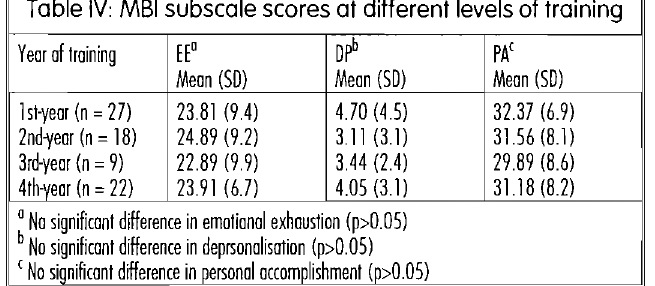
Table IV: MBI subscale scores at different levels of